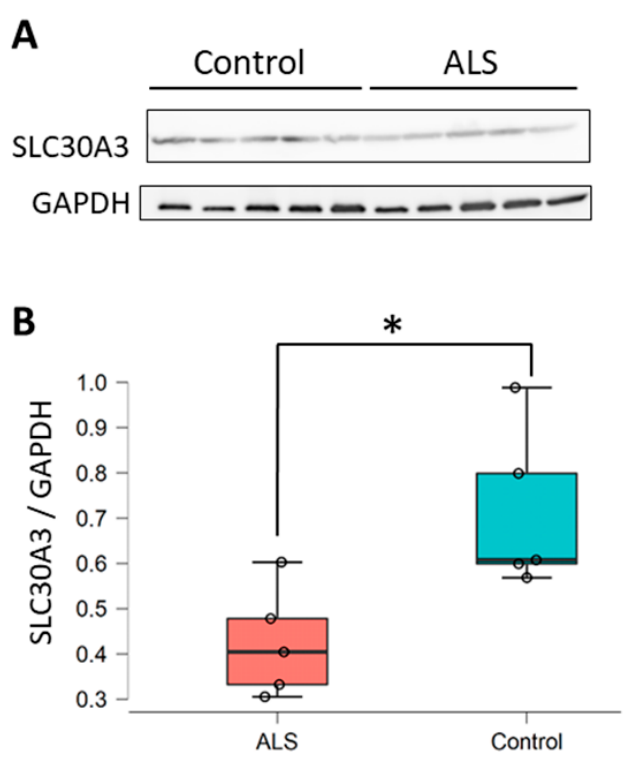
Figure 2. Determination of SLC30A3 was performed using spinal cord samples from patients with sALS. ( A ) The levels of SLC30A3 in the spinal cord were determined by Western blotting analysis. Samples from five patients in each experimental group (control; n = 5 and ALS; n = 5) were examined. ( B ) SLC30A3 in the spinal cords of sALS patients was quantified (control; n = 5 and ALS; n = 5). Data are presented as box and scatter plot calculated from the band intensity of the Western blot. Statistical significance was determined by Student’s t -test (* p <